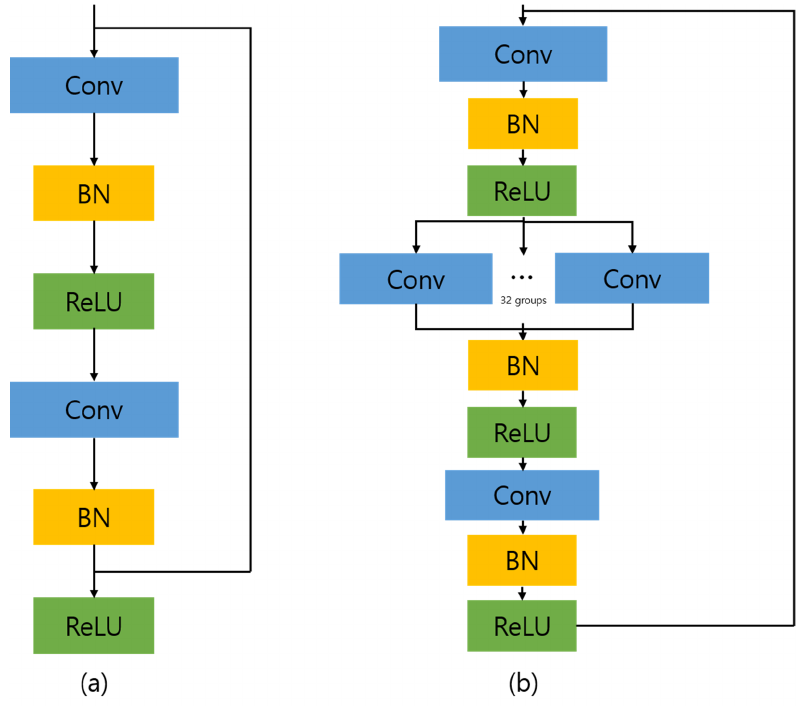
Figure 3. ( a ) ResNet framework and ( b ) ResNext